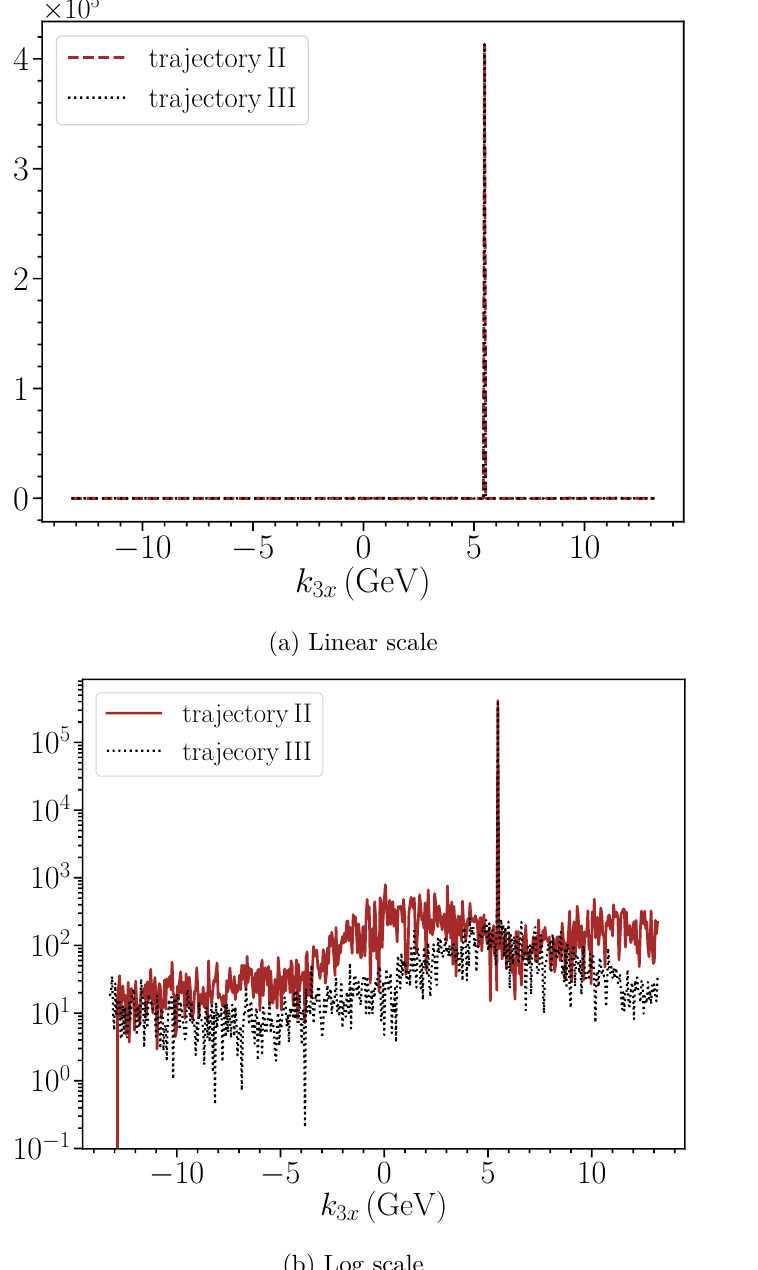
Figure 2. Four-Wilson-line correlator h Tr[ U ( k 1 ) T a U T ( k 2 ) U ( k 3 ) T a U T ( k 4 )] i peaks at k 3 = − k 2 . The figures are exampled by choosing k 2 = ( − 5 . 48GeV , 0) . When varying k 3 , two different trajec- tories passing through − k 2 on the transverse plane are